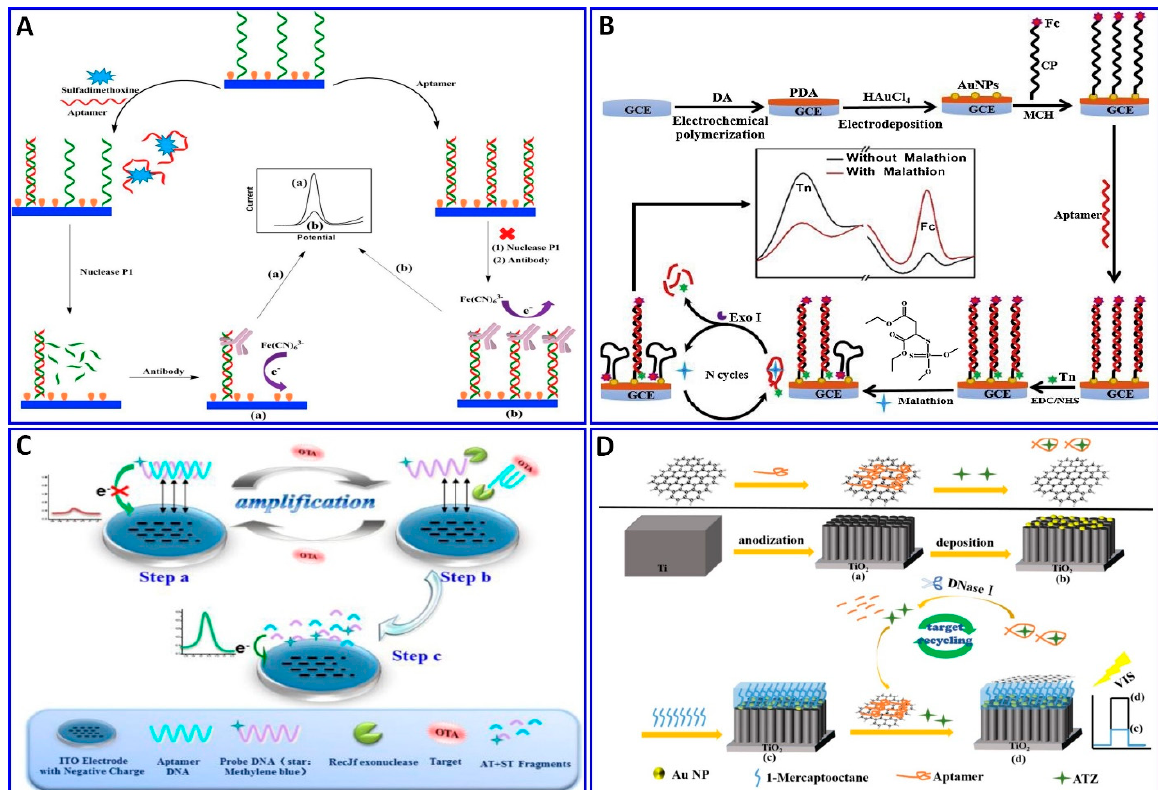
Figure 11. ( A – C ) Schematic protocols for electrochemical aptasensor integrated with signal amplification based on nuclease strategy. ( A ) Assaying of sulfadimethoxine using gold electrode fabricated with dsDNA consisting of DNA probe and specific aptamer for sulfadimethoxine inhibiting nuclease digestion, reproduced from [203]. ( B ) Malathion assay with the assistance of Exo I as a signal enhancer and layer of PDA-AuNPs deposited on GCE as an electrical conductivity enhancer, reproduced from [204]. ( C ) OTA assay using TiO 2 nanotube electrode functionalized with DNA probe tagged with MB, reproduced from [205]. ( D ) Schematic protocols for photoelectrochemical aptasensor ATZ assay with nuclease signal amplification using TiO 2 nanotube covered by a layer of AuNPs, further functionalized with ATZ aptamer/graphene mixture as a sensor probe, reproduced from [206].